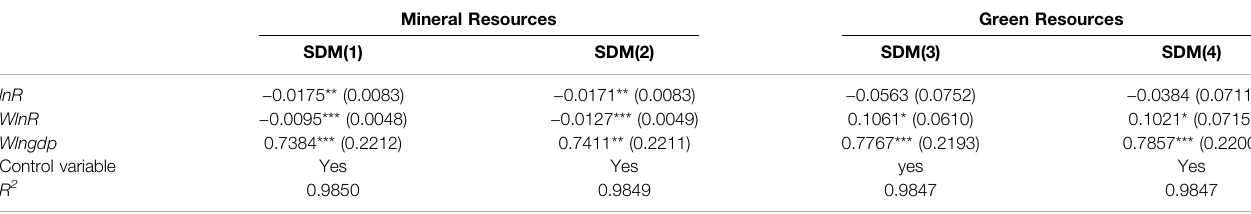
TABLE 7 | Regression results of Classi fi cation discussion and robustness test (Green resources and mineral resources). Mineral